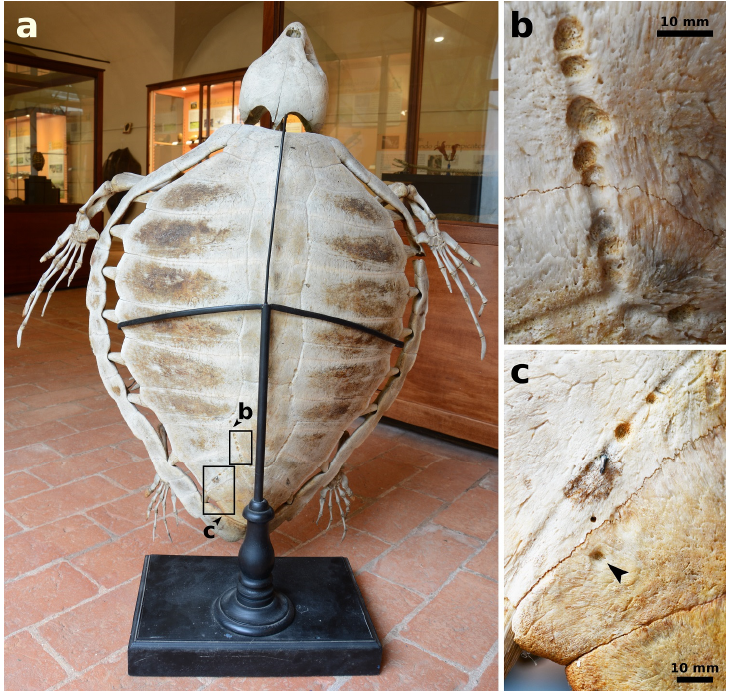
Figure 4. Recent skeleton of Caretta caretta , kept at Museo di Storia Naturale dell’Università di Pisa (Pisa, Italy) with catalogue number MSNUP B32, in dorsal view. ( a ) General view of the skeleton. ( b ) Close-up of some shallow hemispherical/hemiellipsoidal borings occurring along two scute sulci. ( c ) Close-up of an isolated shallow hemispherical boring (indicated by an arrowhead). Modified after Collareta et al. [27].